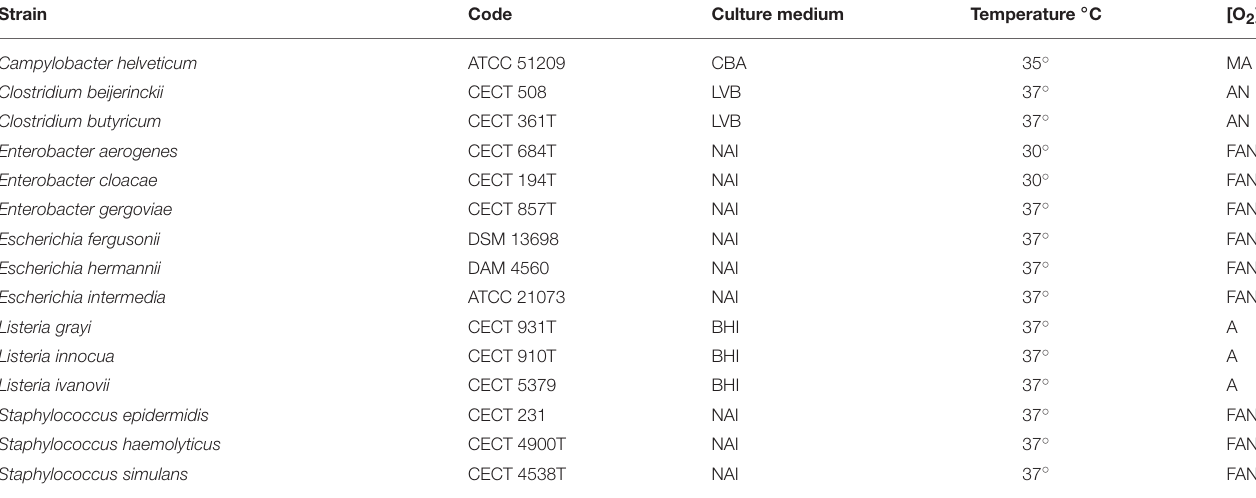
CFUs after mixed CFUs when Salmonella sp. at enrichment (SD) low initial concentration (SD)